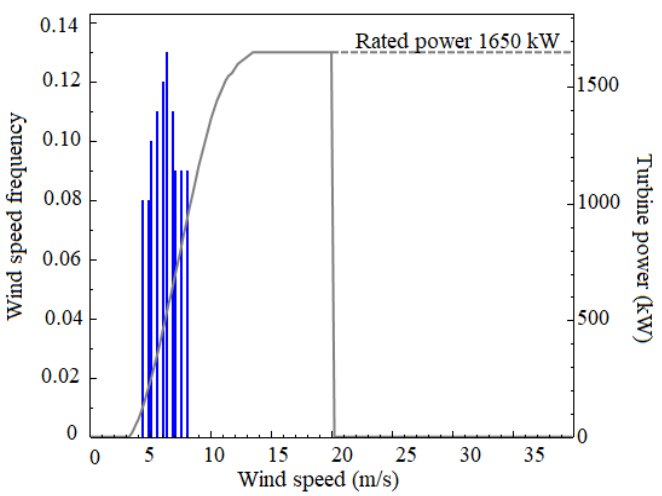
Figure 10. Distribution of the wind speed’s probability of occurrence.